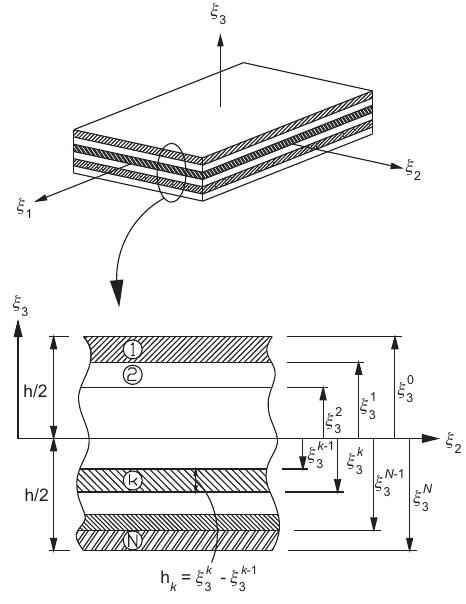
Figure 2 Cross-section of composite laminates composed of N